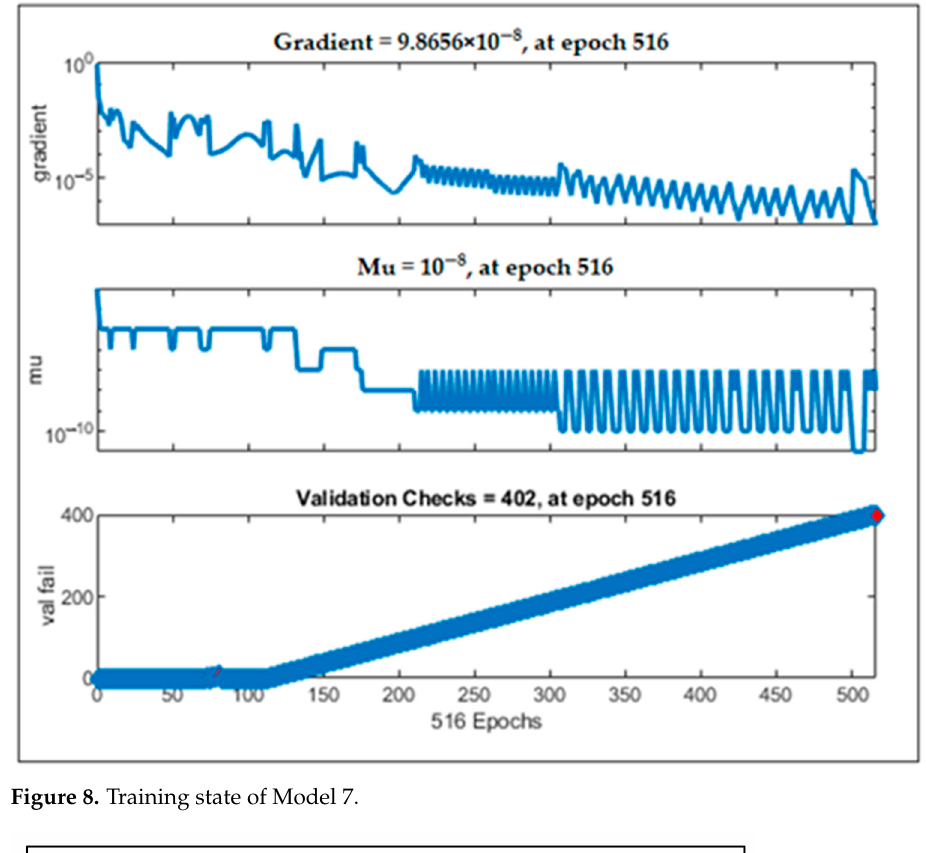
Figure 7. Validation performance of Model 7.